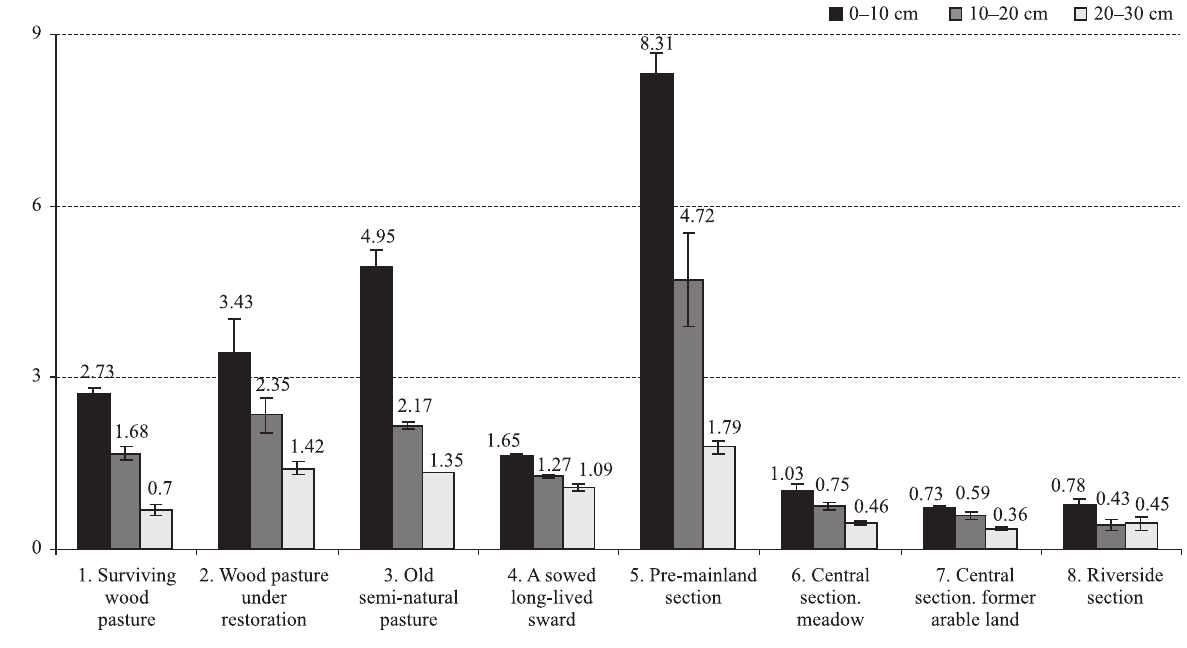
Fig. 2. SOC content (%) in different layers of soil (0–10, 10–20 and 20–30 cm), 2012 Note: vertical bars indicate standard error of means, n =